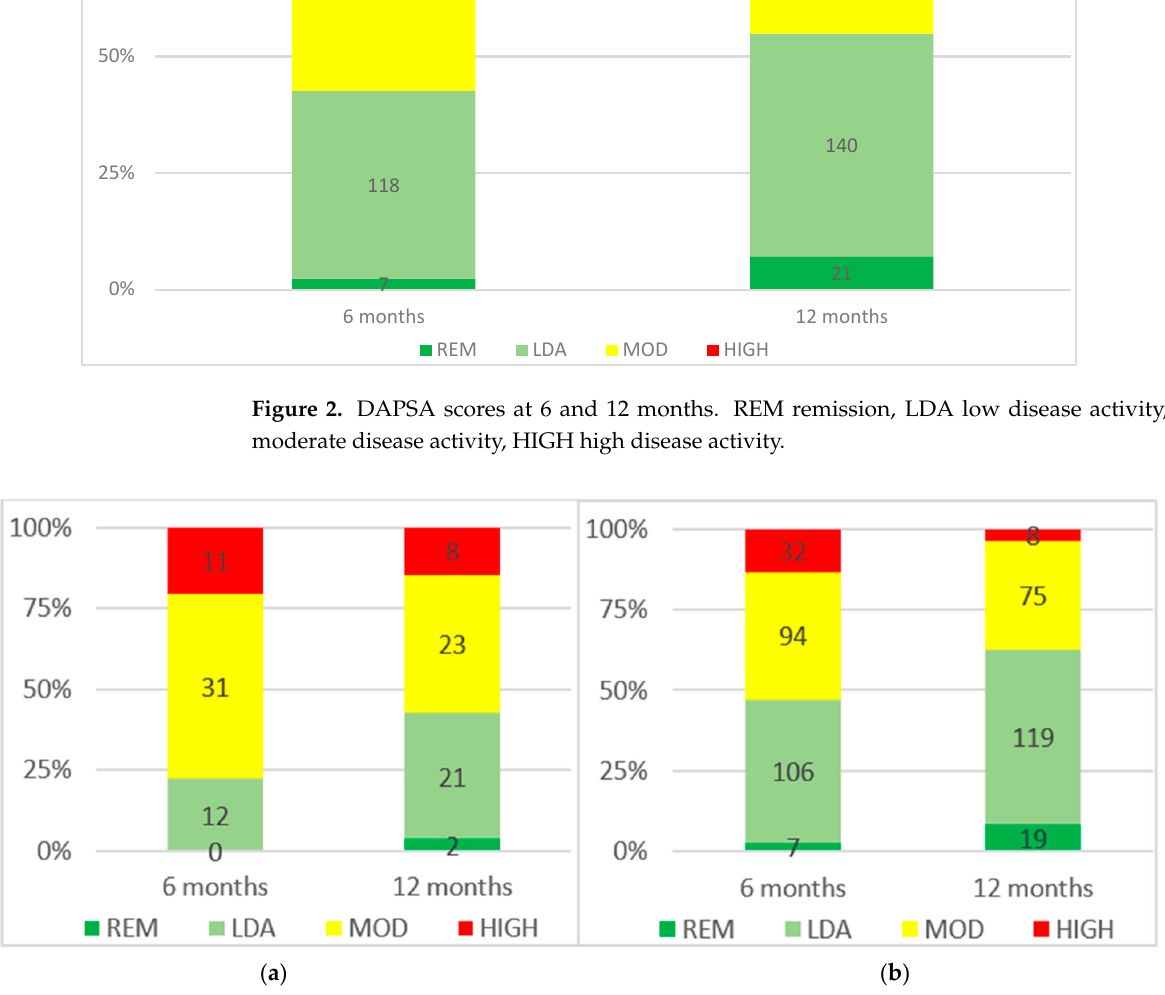
Figure 3. DAPSA scores at 6 and 12 months in PLG ( a ) and RWG ( b ). REM remission, LDA low disease activity, MOD moderate disease activity, HIGH high disease activity.